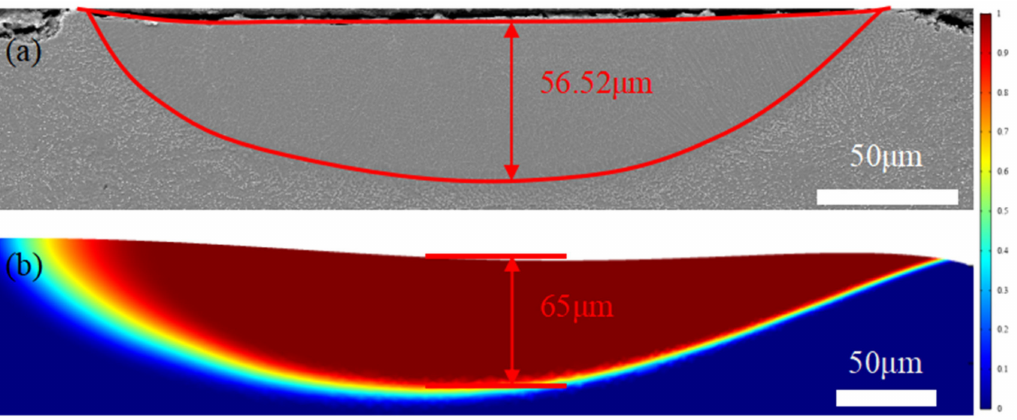
Figure 18. Experimental verification: ( a ) actual weld pool shape and ( b ) simulated shape of molten pool at t = 14